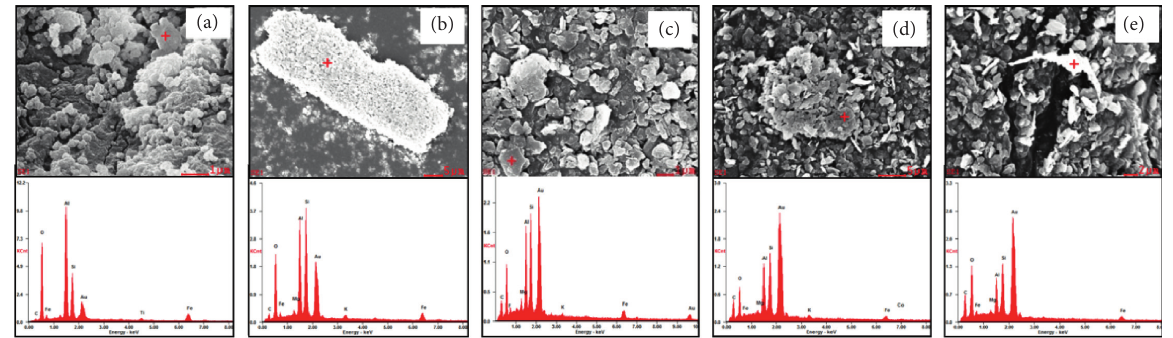
Figure 3: SEM/EDS of selected horizons of the profiles less than 2 μ m in particle size. (a) Allophane in Pyeongdae Bw2 horizon; (b) illite; (c) chlorite in Jeju Bt2 horizon; (d) kaolinite and (e) vermiculite in Gangjeong Bt2